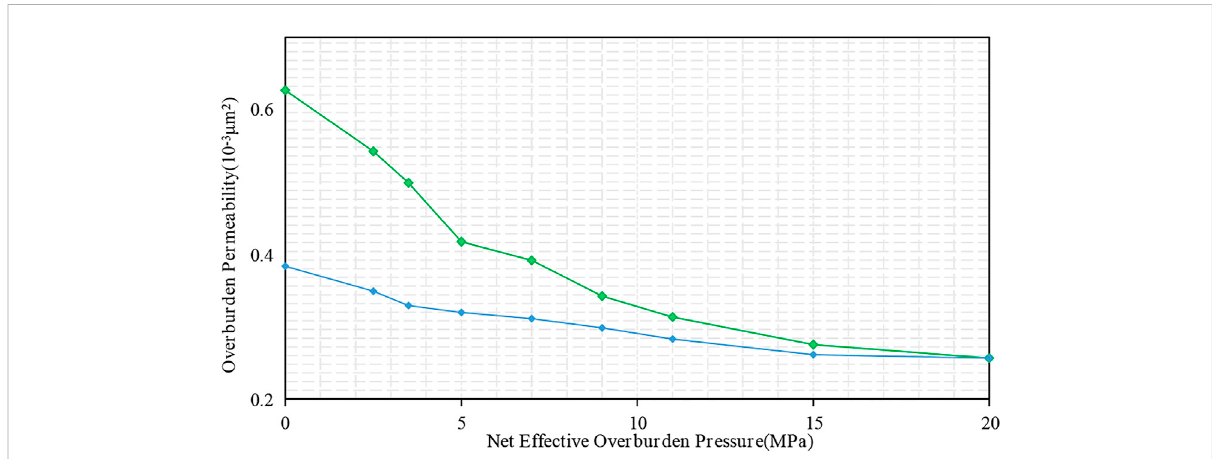
Relationship between overburden permeability and pressure change as a whole process.